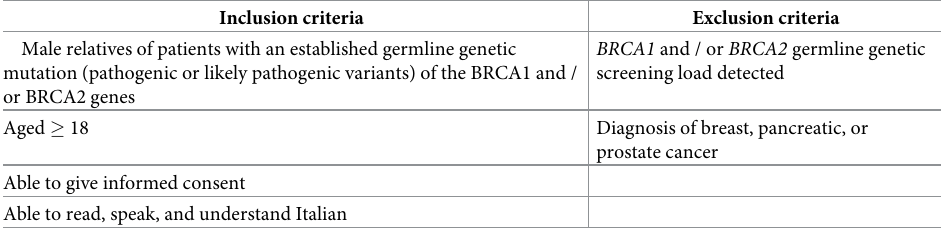
Table 1. Inclusion and exclusion criteria for the male